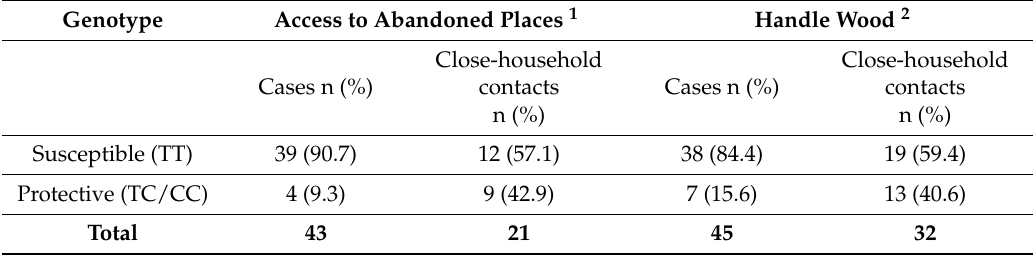
Table 3. Distribution of SNP rs5918 genotypes among ANDV cases and uninfected close-household contacts exposed to the same risk